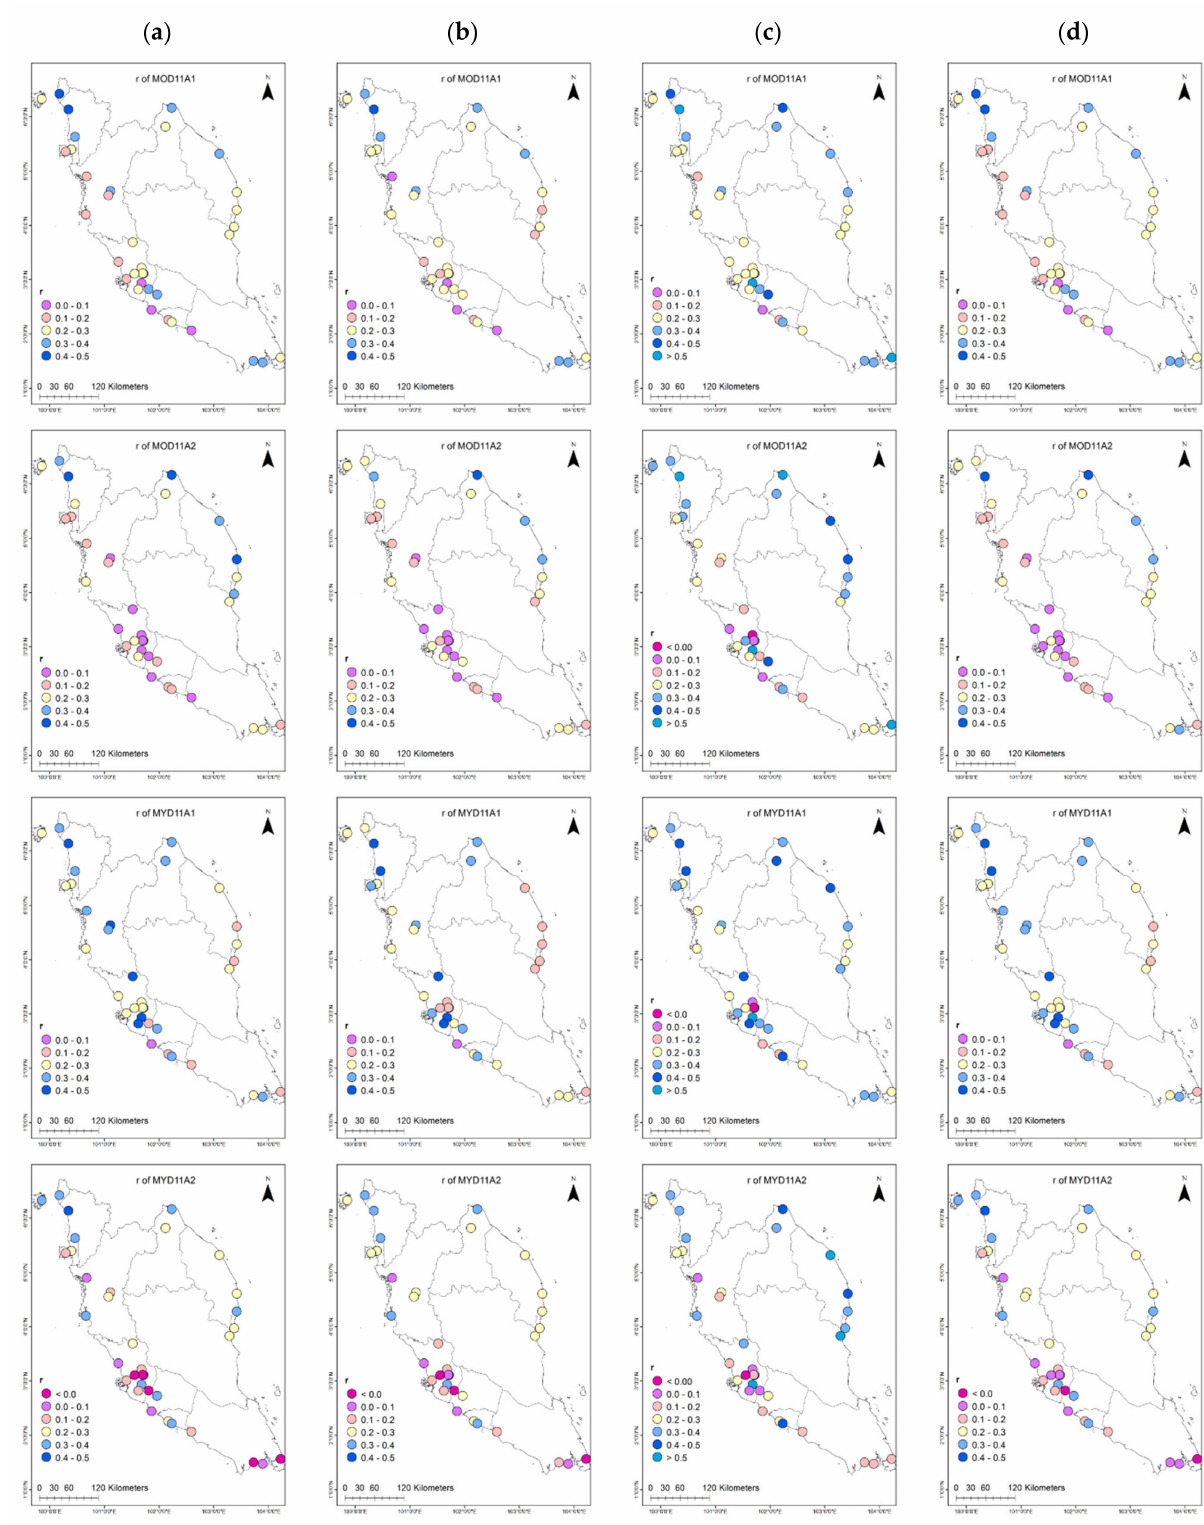
Figure 9. Distribution of r for comparison between simulated data, ( a ) T s , ( b ) T scd , ( c ) T scm , and ( d ) T scq , and observed data, T a